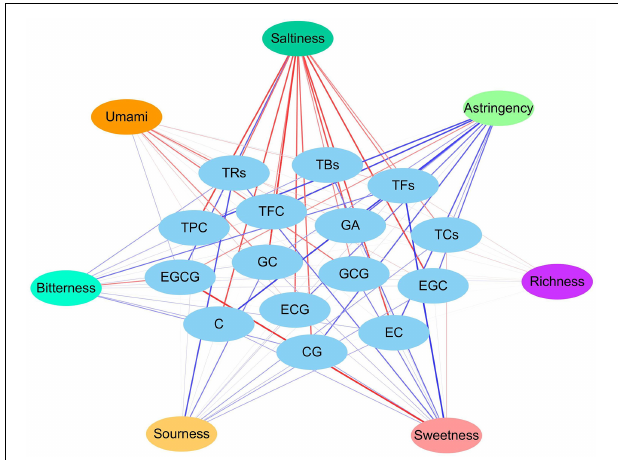
FIGURE 10 | Network correlation analysis of the taste profile and the main metabolites.